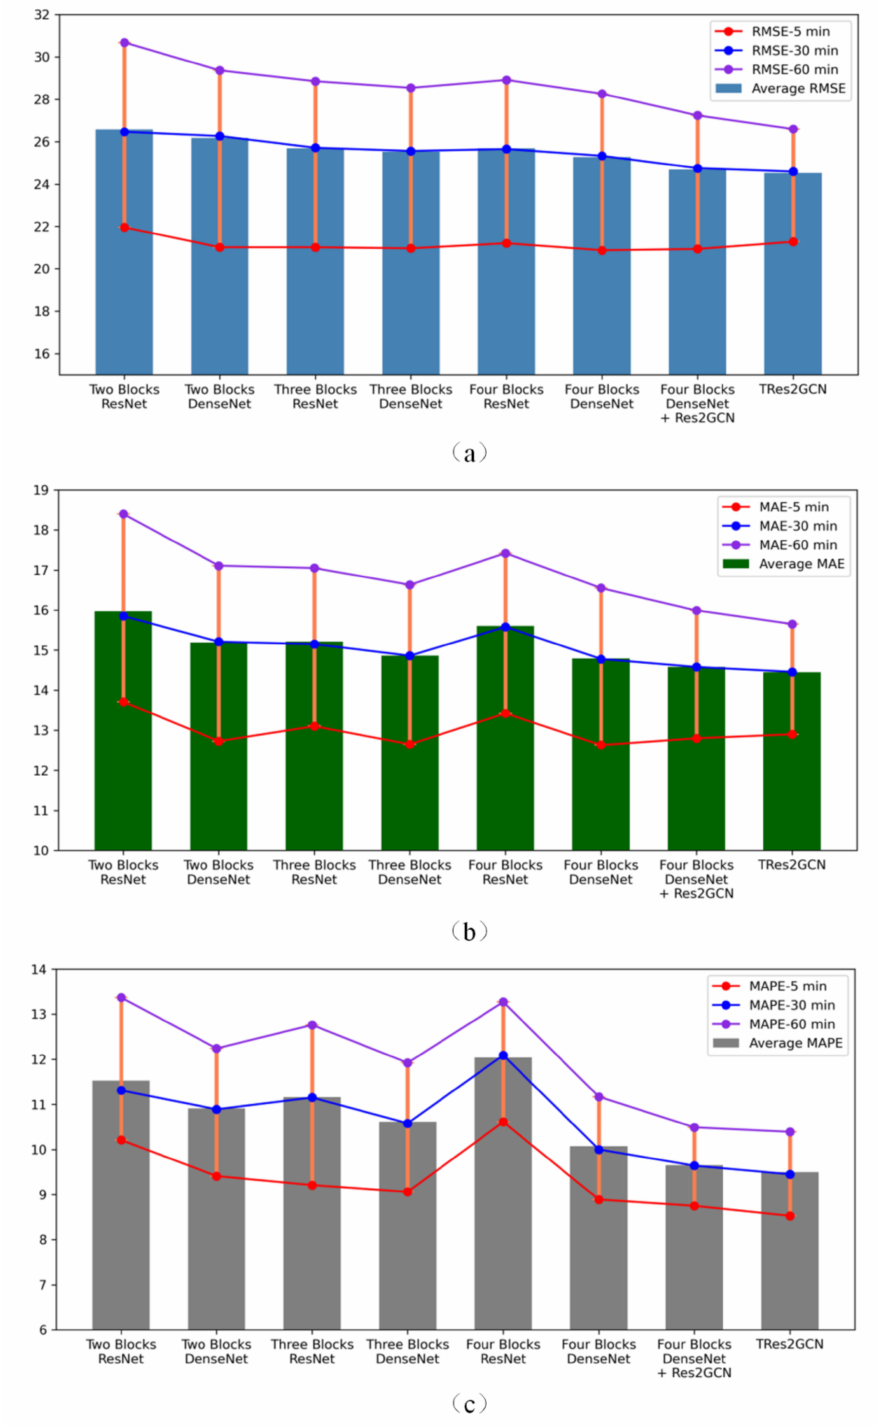
Figure 4. Visualization of the impact of components on the prediction error (PeMS08 as an example), ( a ) RMSE, ( b ) MAE and ( c ) MAPE; the error bars represent the floating changes of the predicted metrics in 60 min; the red line represents the outcome metrics predicted in 5 min; the blue line represents the outcome metrics predicted in 30 min; the purple line represents the outcome metrics predicted in 60